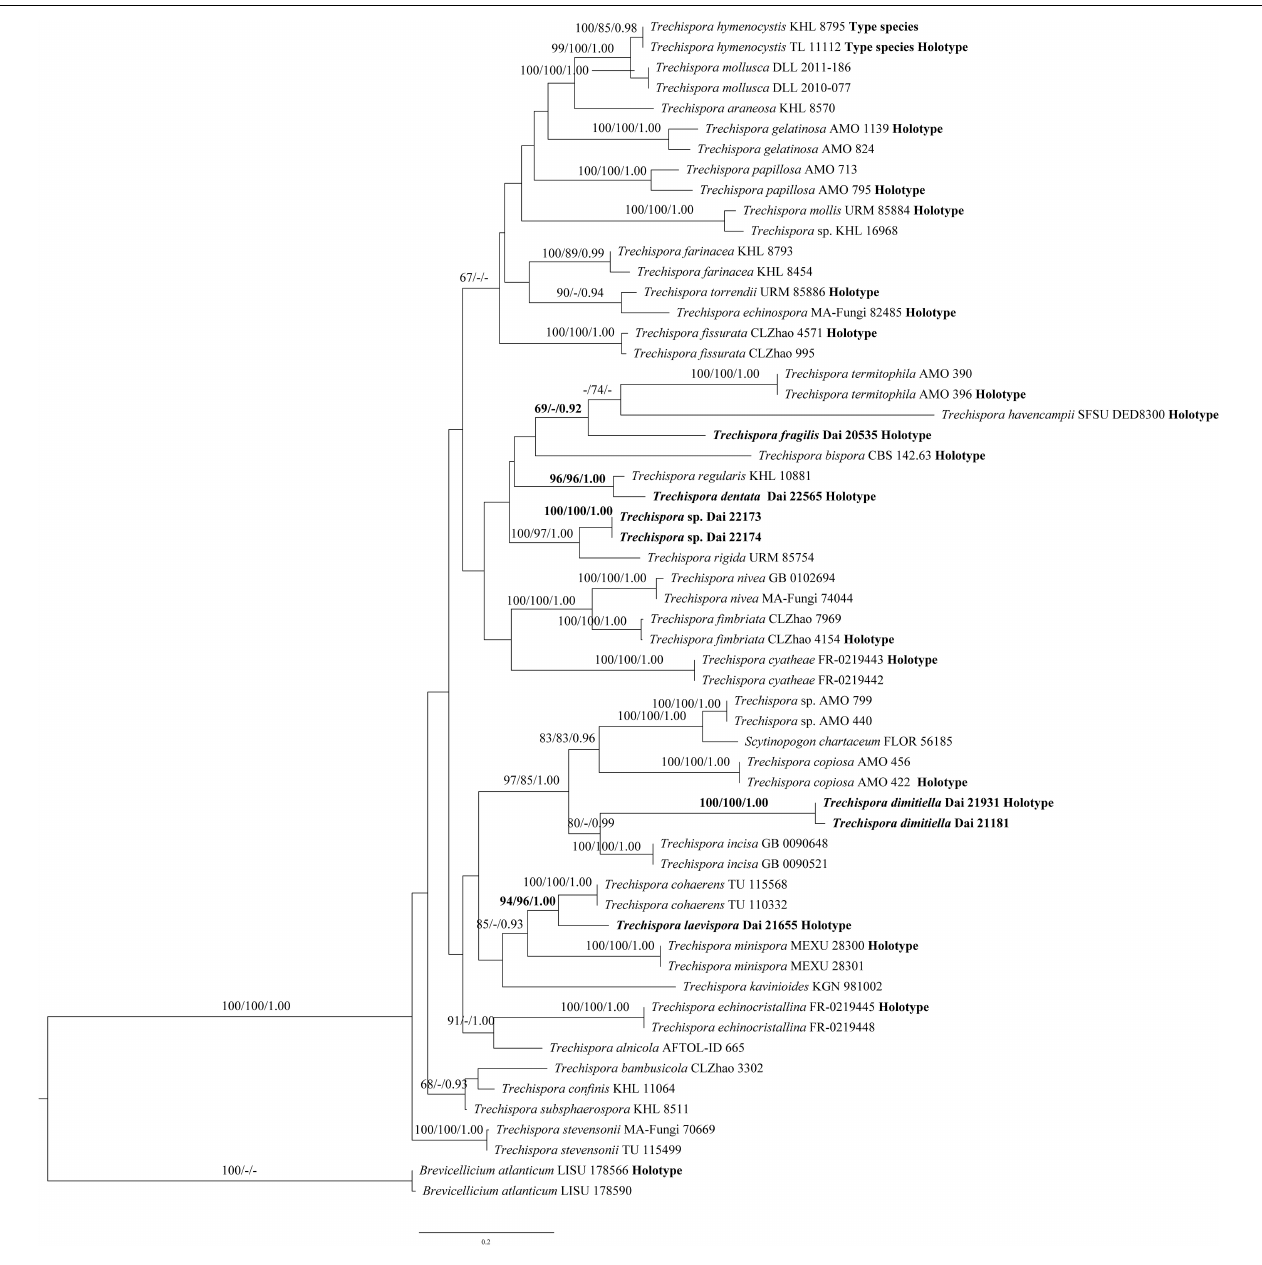
FIGURE 2 | Phylogeny of Trechispora generated by ML analyses based on combined ITS sequences. Branches are labelled with ML BT > 65%, Parsimony Bootstrap Proportions > 70%, and BPP > 0.90, respectively. Putatively new species, the sequence origin from the holotype, and the type status of the species in the genus are indicated in